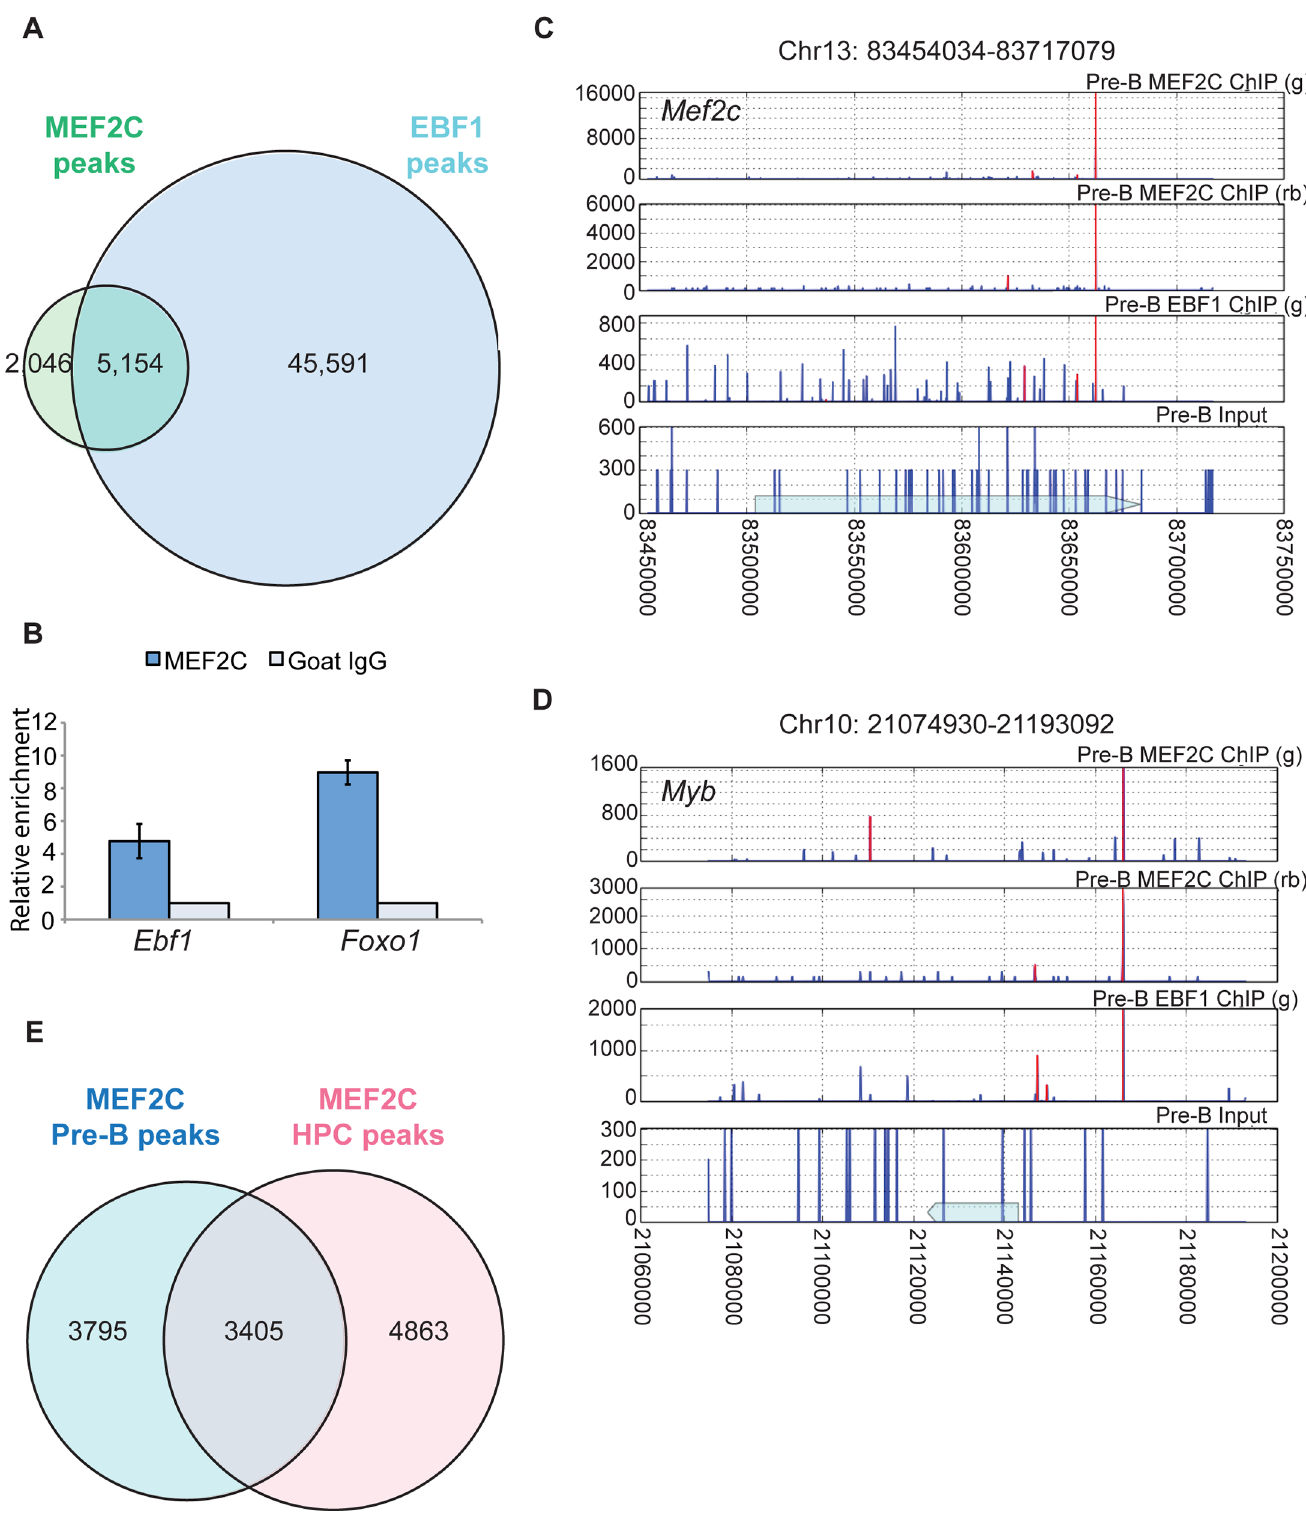
Fig 2. MEF2C and EBF1 co-occupy many B lineage genes. (A) Venn diagram of MEF2C and EBF1 overlapping ChIP-seq peaks in pre-B cells. MEF2C peaks are those commonly shared in two separate ChIP experiments, as shown in S2A Fig. (B) ChIP-qPCR validation of MEF2C binding near Ebf1 and Foxo1 genes. (C, D) Representative MEF2C and EBF1 ChIP-seq profiles at Mef2c and Myb loci, with the corresponding antibody used in the ChIP